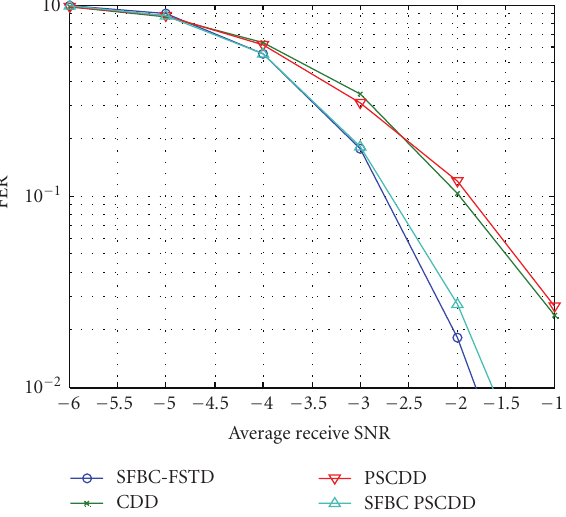
Figure 2: BLER performance in correlated channels. Figure 3: BLER performance in uncorrelated